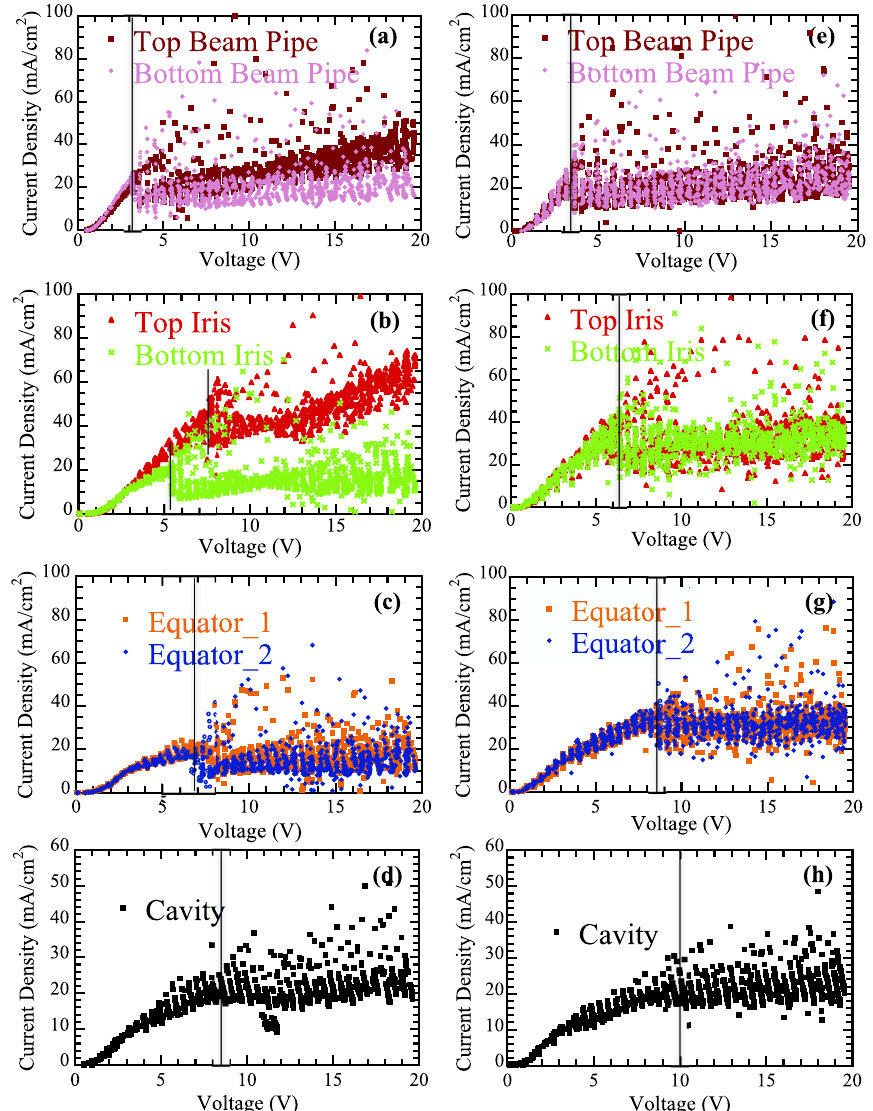
FIG. 17. Polarization curves obtained for the beam pipe, iris, and equator coupons, and cavity with NC-3 at 0 rpm (a) – (d) and 50 rpm (e) – (h). The solid vertical lines represent a transition from the etching region to the oscillation region followed by the polishing